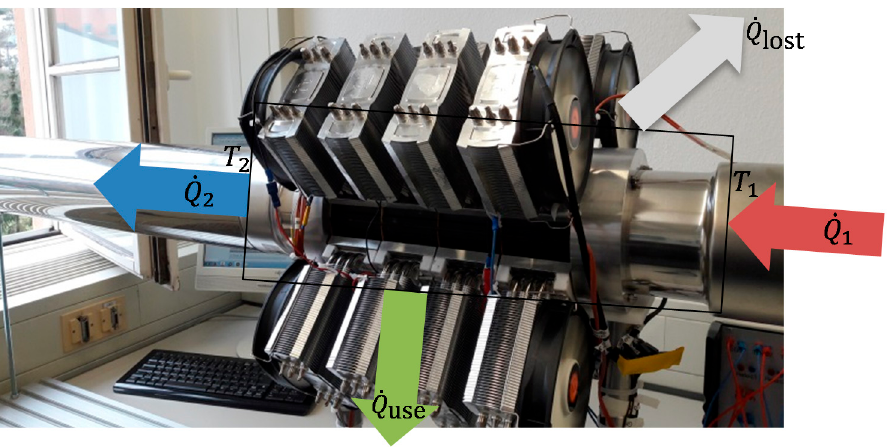
Figure 10. Schematic system consideration of the heat flow rates for the EHS at the heating mockup.